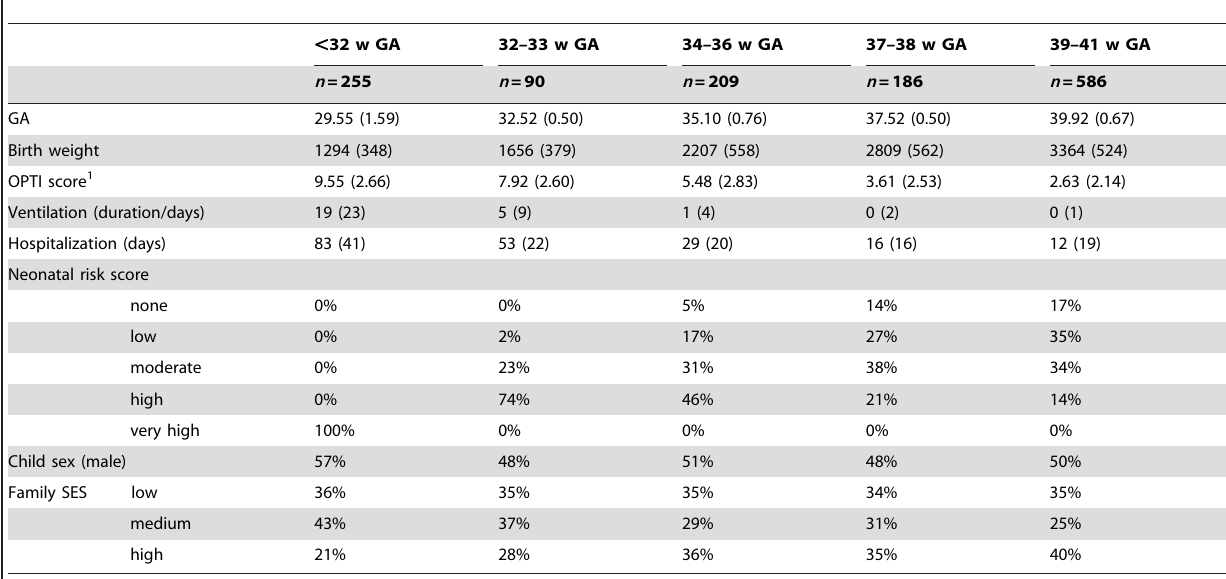
Table 1. Sample characteristics of the weighted BLS Phase II study participants according to gestational age groups (cases with severe neurological impairment excluded) at 8;5 years.